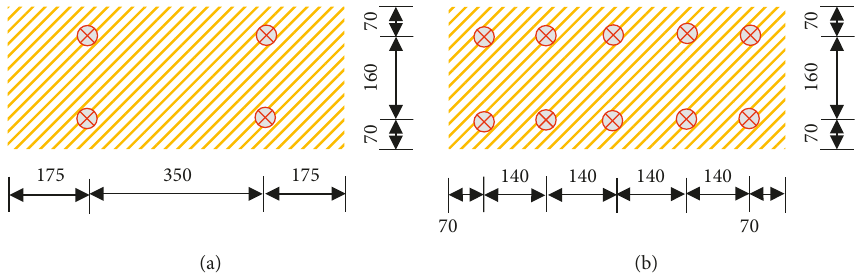
Figure 12: Bolt patterns of specimens in series III (unit: mm). (a) B5. (b) B6.